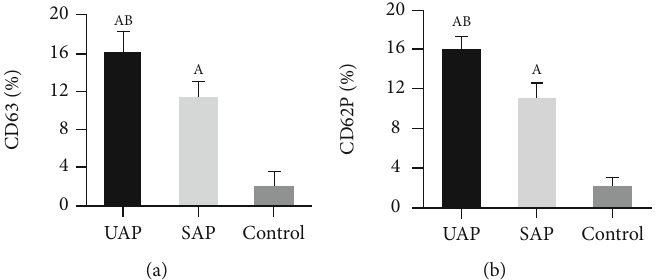
Figure 3: Comparison on levels of CD63 and CD62P. (a, b) The comparison of CD63 and CD62P, respectively. A and B suggested the di ff erence was obvious to the control group and SAP group, respectively ( P < 0 : 05